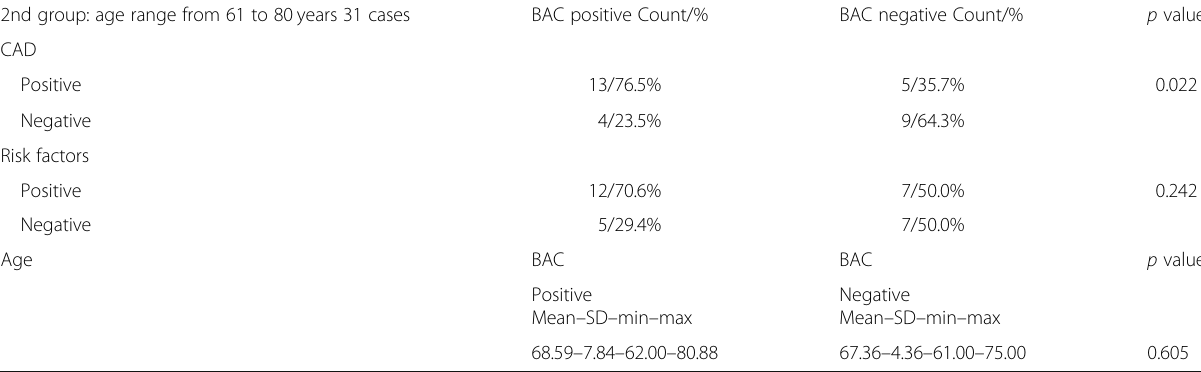
Table 4 Relation of BAC in 2nd group (61 to 80 years) with age, cardiac conditions, and risk factors 2nd group: age range from 61 to 80 years 31